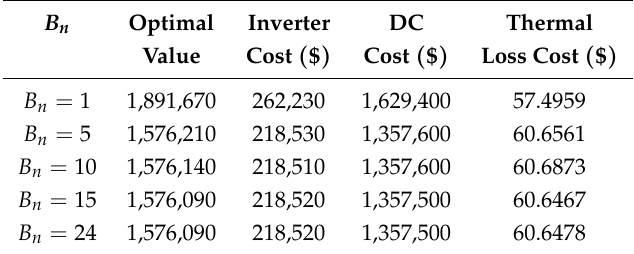
Table 7. Optimal values and